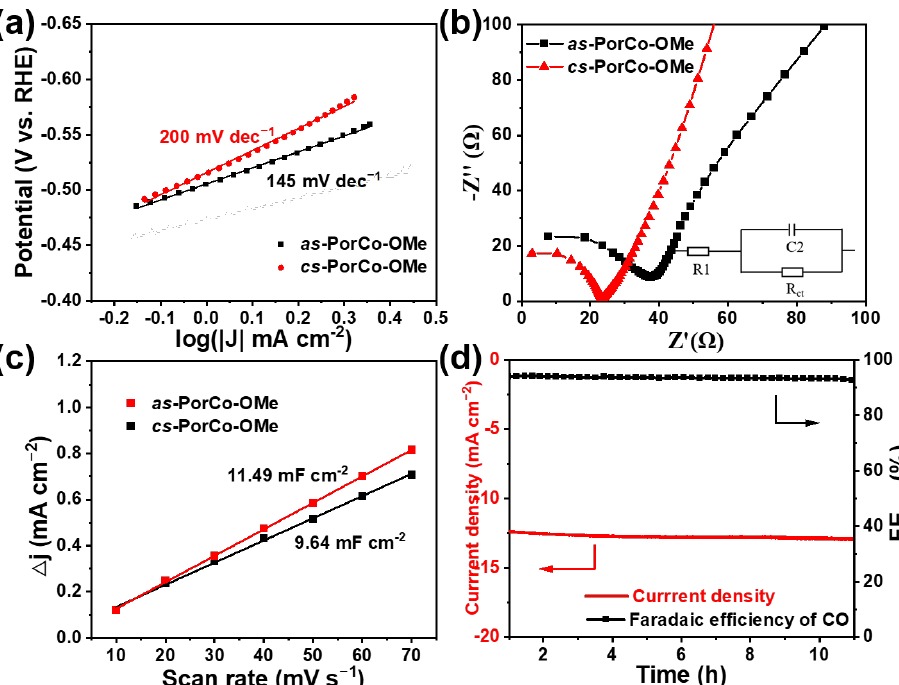
Figure 6. ( a ) Tafel slopes and ( b ) Nyquist plots of as -PorCo-OMe and cs -PorCo-OMe; ( c ) capacitive current as a function of scan rate for as -PorCo-OMe and cs -PorCo-OMe; ( d ) long-term stability of as -PorCo-OMe at − 0.7 V vs. RHE for 12 h.